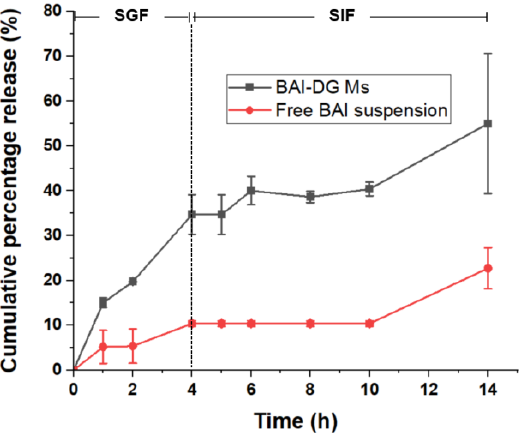
Figure 8. Cumulative percentage release of BAI from BAI-DG Ms and a free BAI suspension as a function of time in simulated gastric fluid (SGF) (0–4 h) and simulated intestinal fluid (SIF) (4–14 h) at 37 °C.